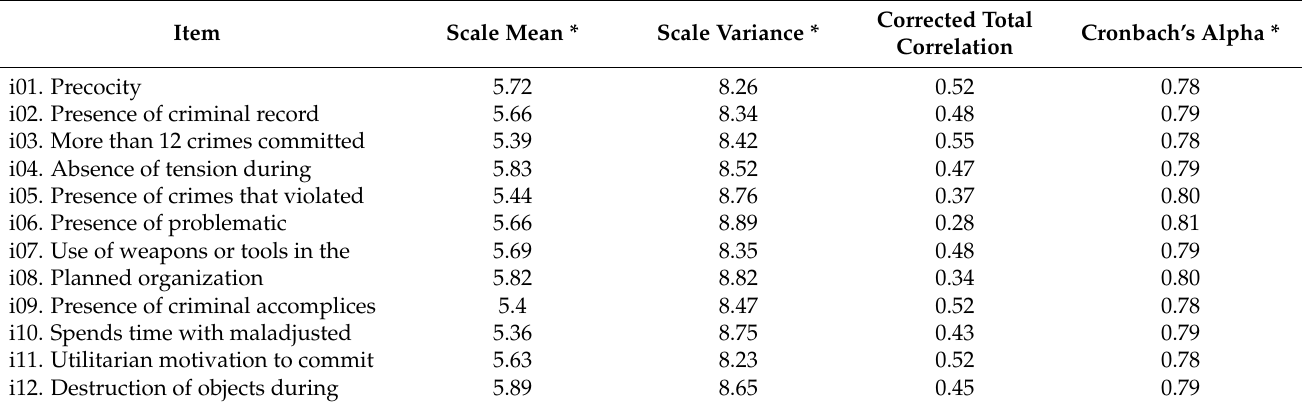
Table 4. Cronbach’s alpha coefficient by item on the EGED.